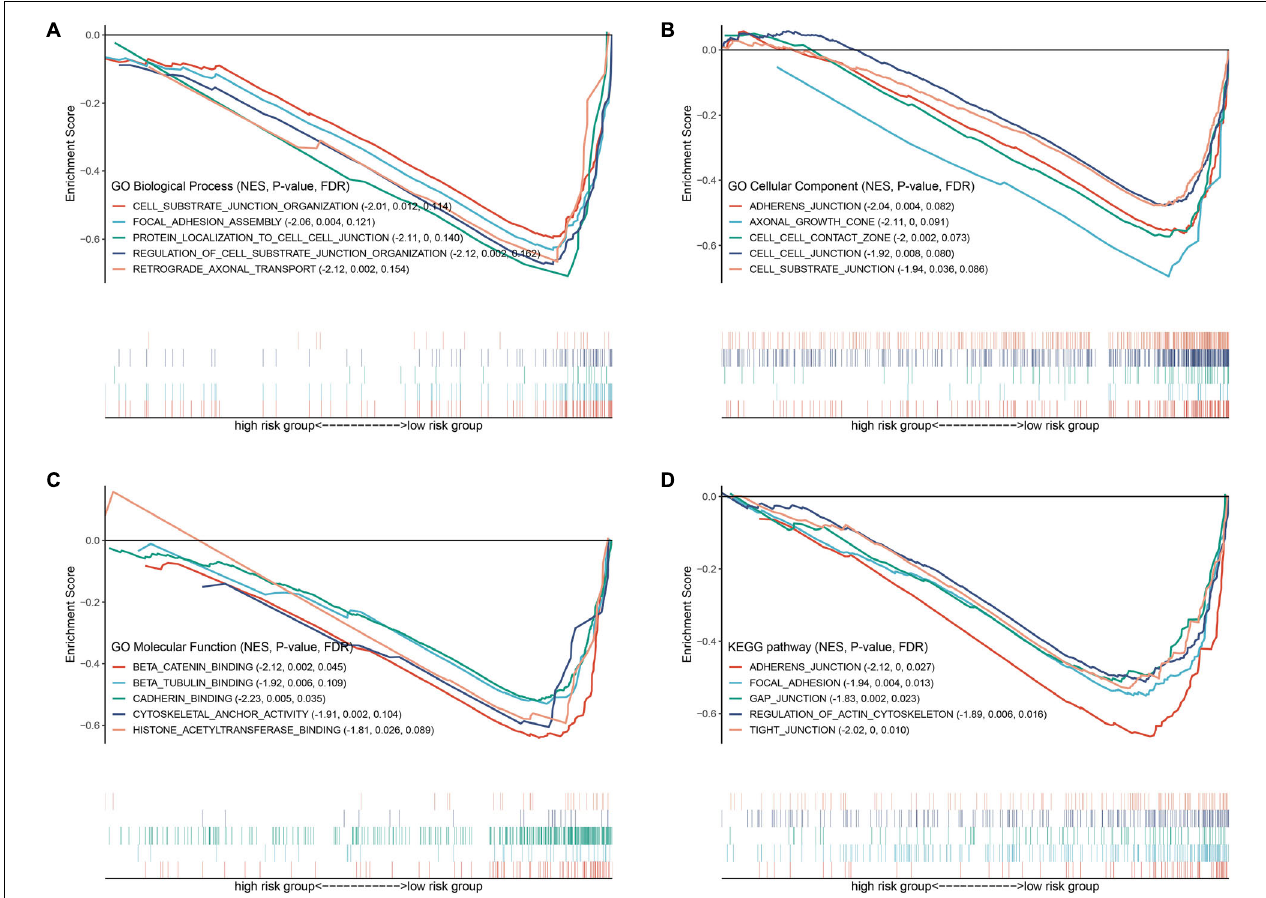
FIGURE 9 | GSEA based GO and KEGG analysis. Gene sets of (A) GO biological process, (B) GO cellular component, (C) GO molecular function and (D) KEGG associated with the signature.